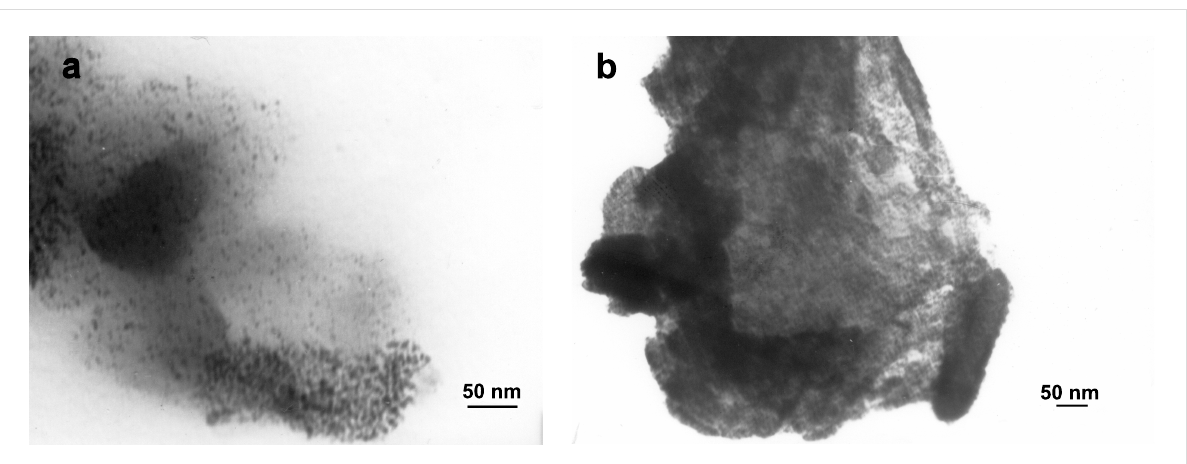
Figure 4: TEM image of the fresh Cell–OPPh 2 –Pd 0 catalyst (a) and the recovered catalyst after being reused six times (b) at the same magnification.